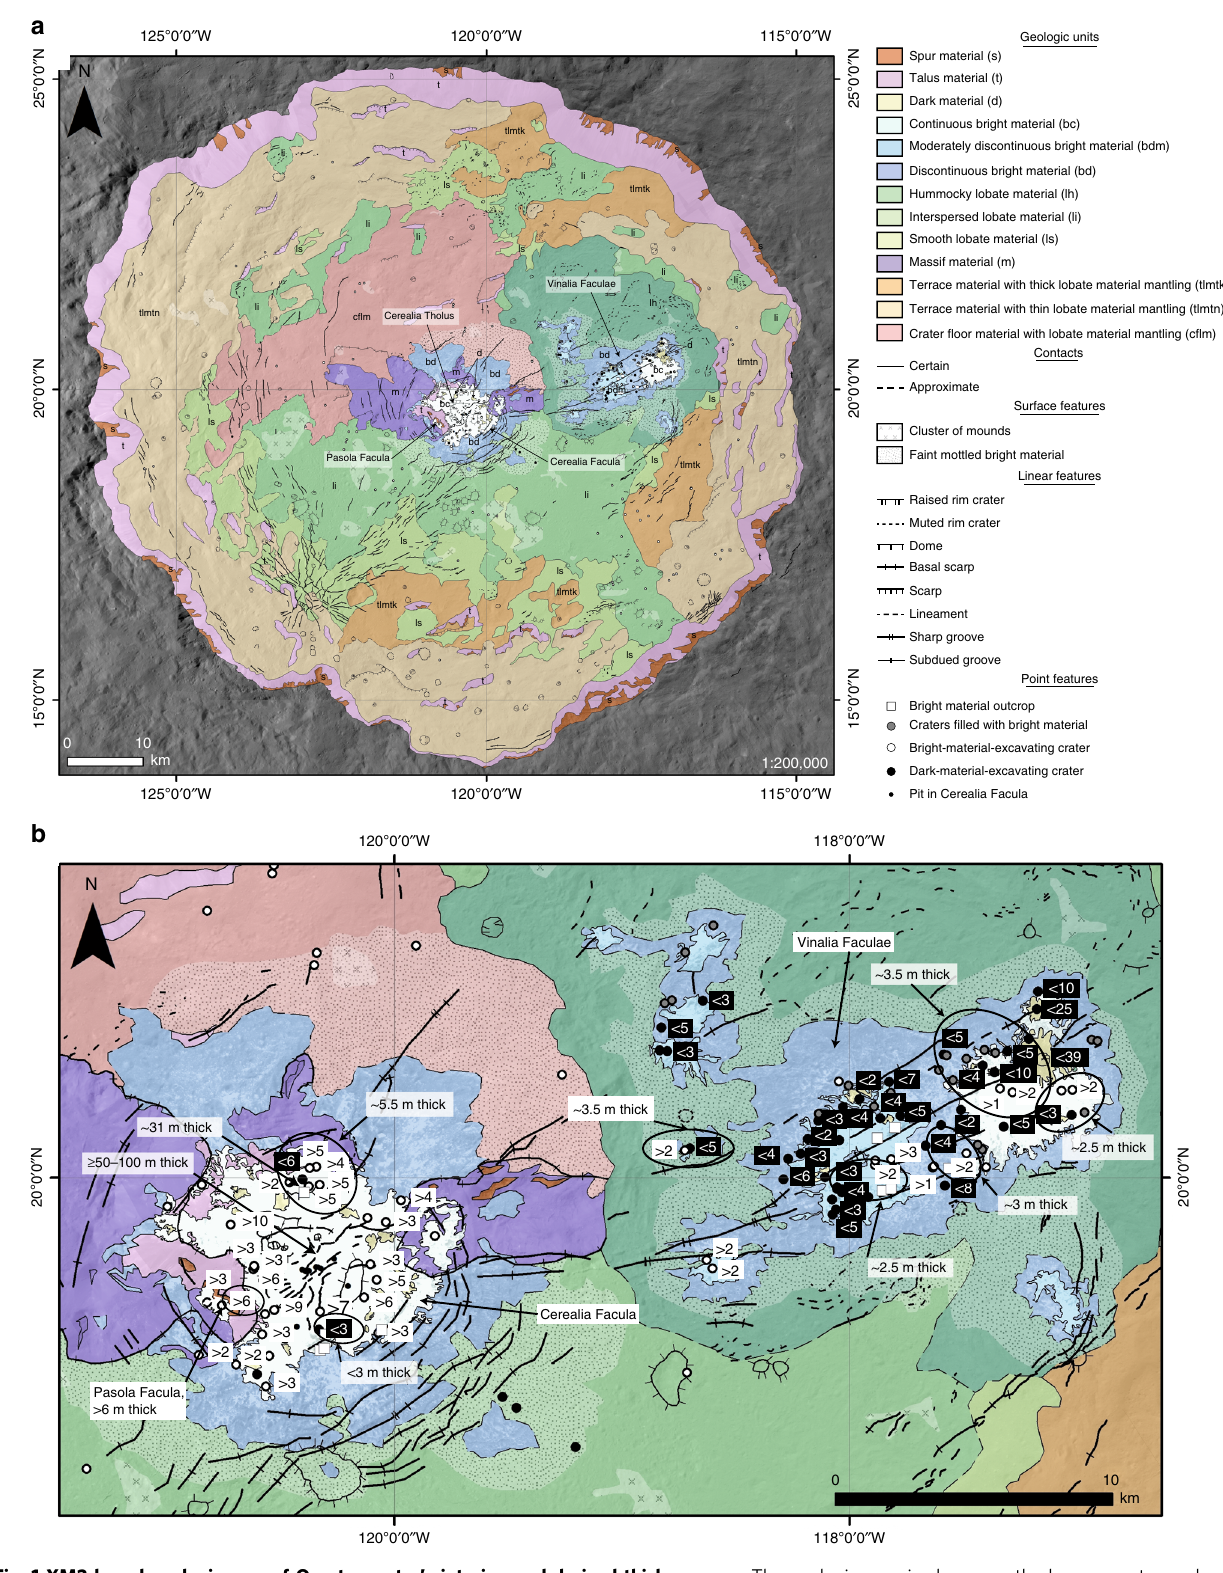
Fig. 1 XM2-based geologic map of Occator crater ’ s interior, and derived thicknesses. a The geologic map is shown on the basemap at a scale of 1:200,000 and with a simple cylindrical projection. The basemap is shown with no mapping in Supplementary Fig. 4. A high-resolution JPEG, stand-alone version of the geologic map is available as Supplementary Data 1. b Detail of the geologic map with thicknesses of Cerealia Facula, Vinalia Faculae, and Pasola Facula derived from: superposing impact craters with dark (white text in black box) or bright (black text in white box) ejecta; an outcrop of bright material (marked by the white square symbol); and fractures on Cerealia Tholus. When thickness estimates were derived for a particular region, the region is de fi ned with a black ellipse. Each thickness estimate is associated to an ellipse by a black